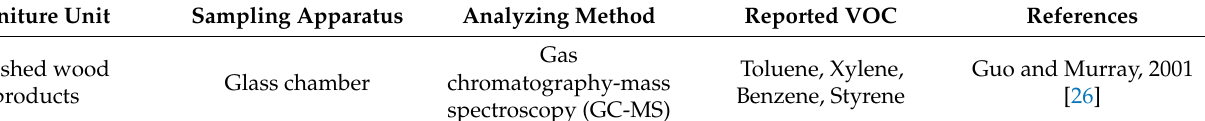
Table 1. VOC emission characteristics from different furniture